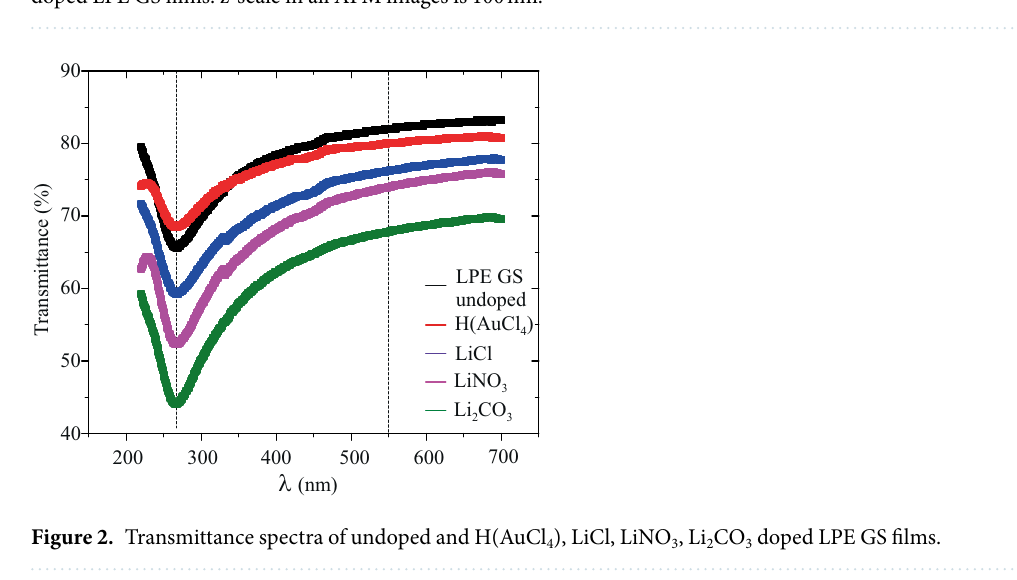
Figure 1. ( a ) Schematic representation of the LPE GS film formation and its doping in the single-step process. ( b1 – f1 ) Optical images are shown in the top row, whereas ( b2 – f2 ) AFM topographic images are shown in the bottom row for the following cases: ( b ) undoped LPE GS film, and ( c ) Li 2 CO 3 , ( d ) H(AuCl 4 ), ( e ) LiCl, ( f ) LiNO 3 doped LPE GS films. z-scale in all AFM images is 100 nm.